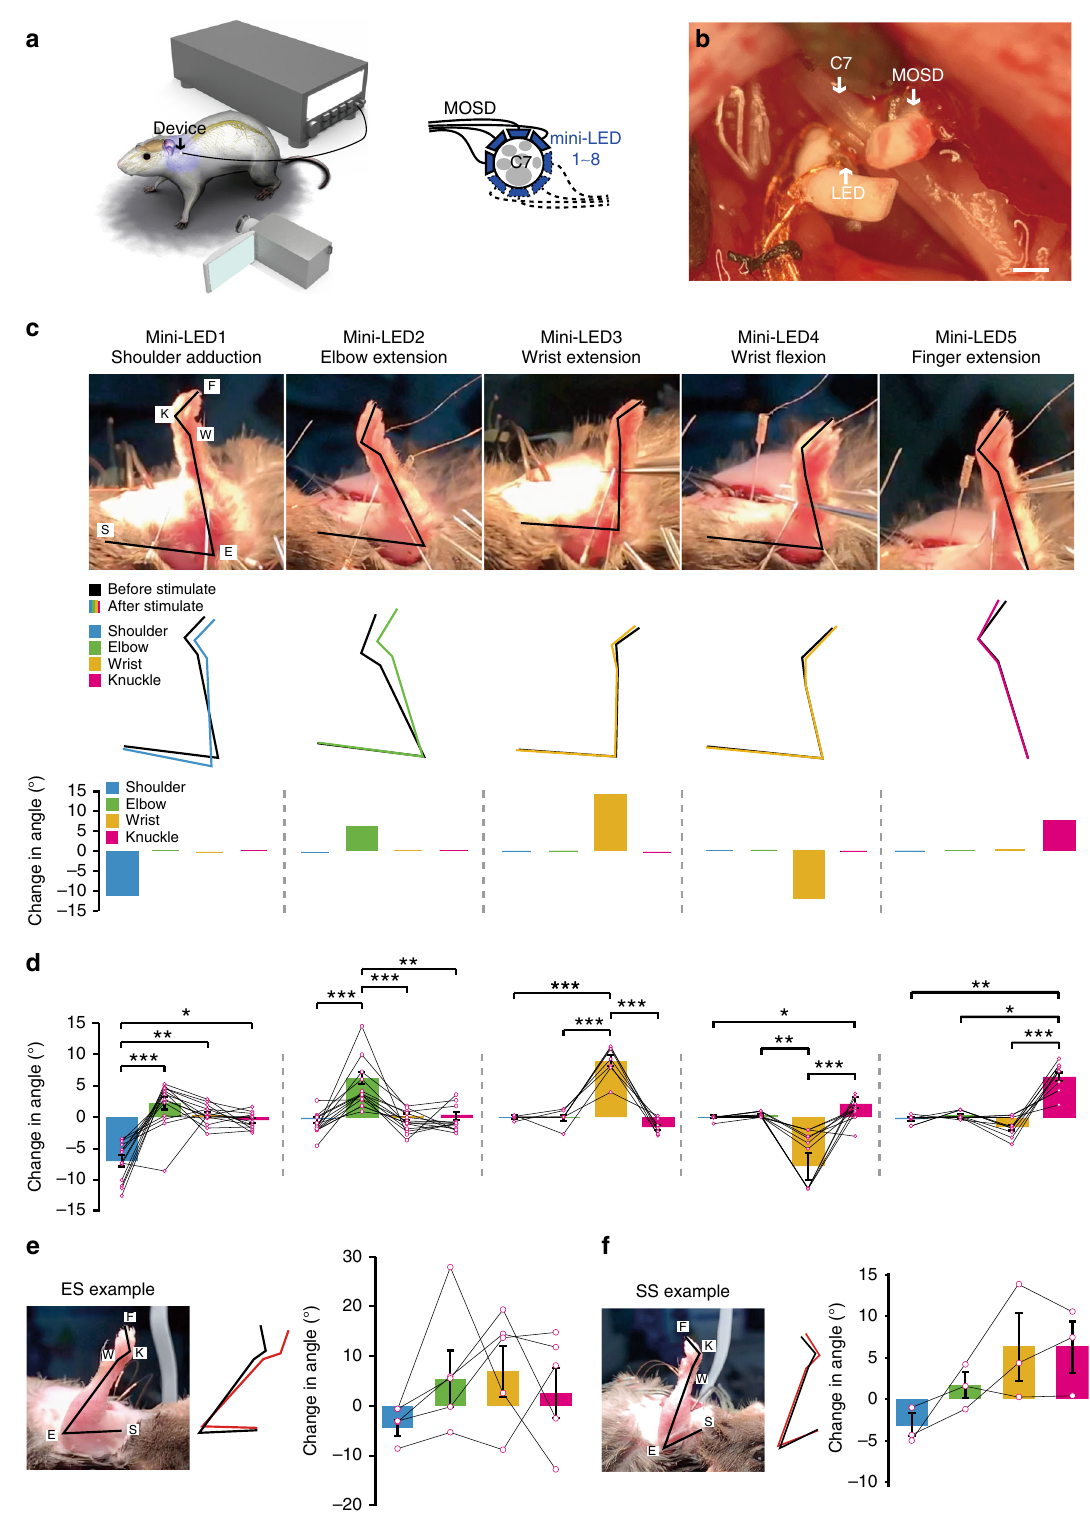
LEDs onto nerve terminals that innervate selective muscles 49 . Many nerve terminal branches are just below the arch and deep into the muscle belly 50 , so dissection of multiple nerve terminals is surgically challenging and causes damage to the surrounding tissue and blood supply to the muscles. Using MOSD, we were able to program the on/off patterns of four mini-LEDs in C7, aiming at maximization of selective muscle activation.